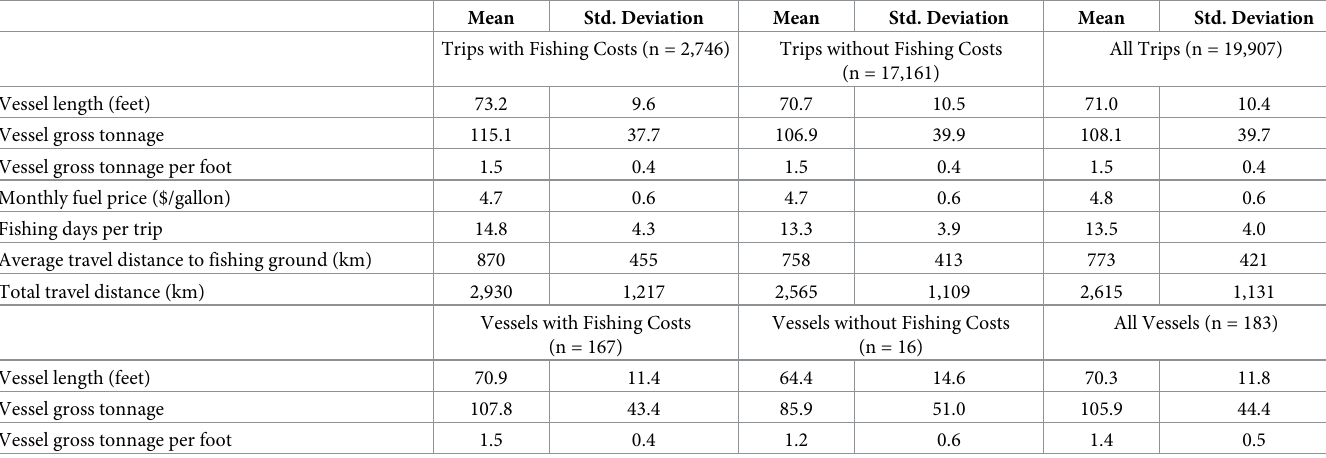
Table 1. Summary statistics of the covariates in Hawaii longline